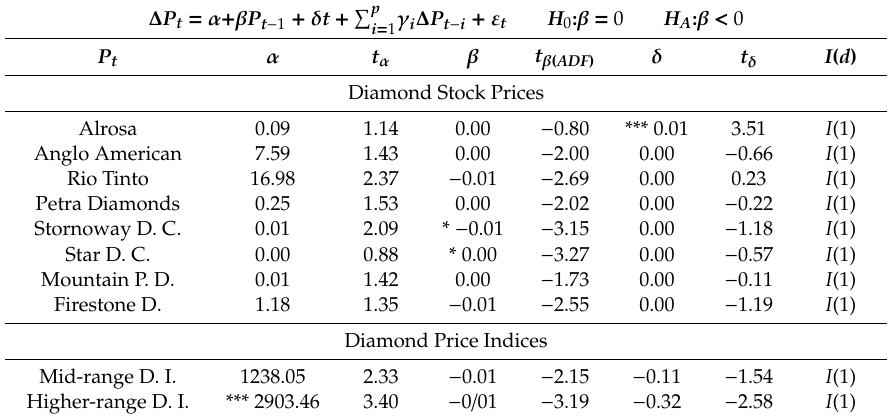
Table 4. ADF test statistics for diamond stocks and diamond indices in levels.